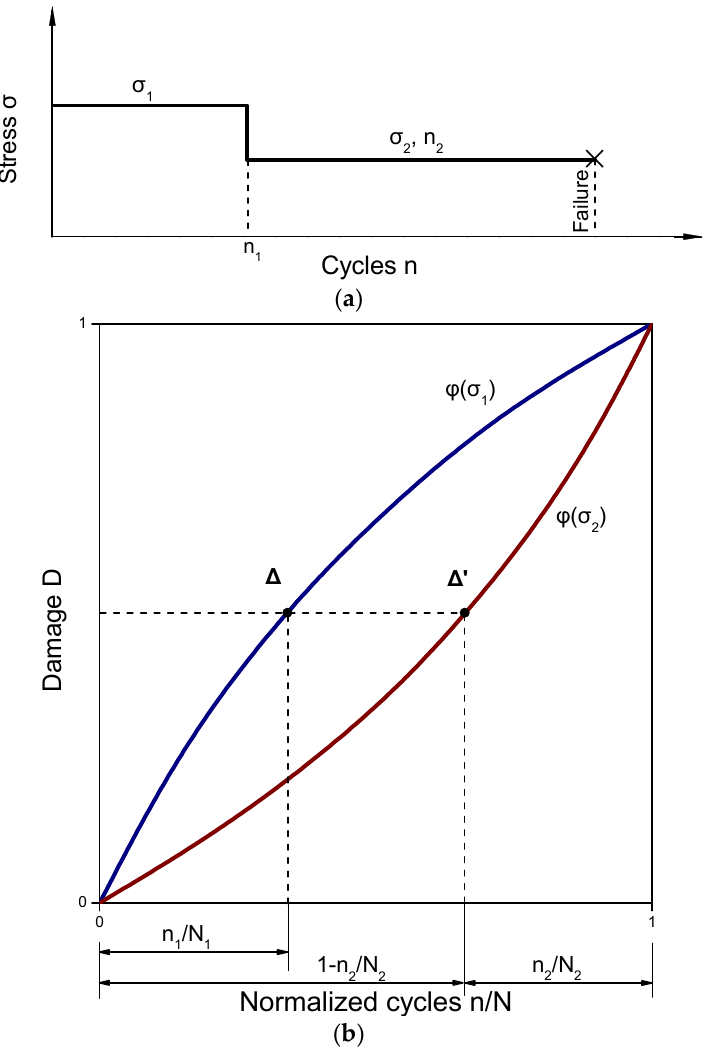
Figure 2. Schematic illustration of fatigue growth until failure: ( a ) loading conditions with respect to cycles; ( b ) fatigue damage with respect to normalized cycles.